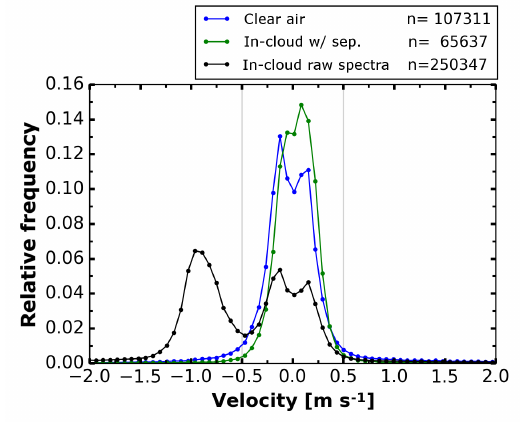
Figure 9. Histogram of RWP vertical velocities for the evening of 17 June (same period as shown in Fig. 8). n denotes the number of spectra that contributed to each class. The minimum at 0ms − 1 in the clear-air and in-cloud raw spectra is caused by the stationary clutter filtering procedure in the original RWP signal